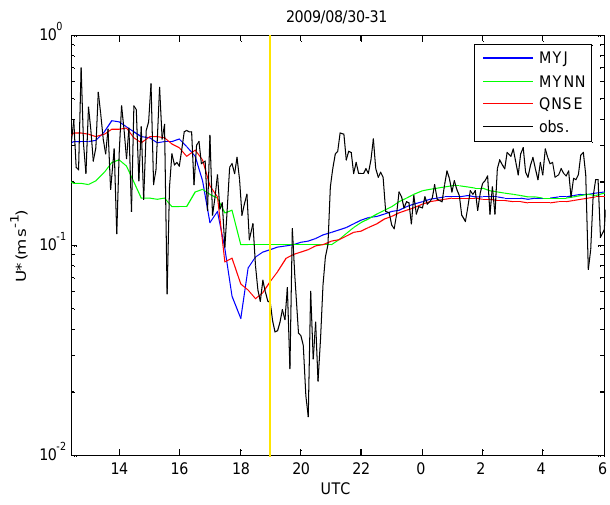
Figure 7. Simulated and observed (5-min averaged) friction veloc- ity for the 30–31 August 2009 transition (type B).